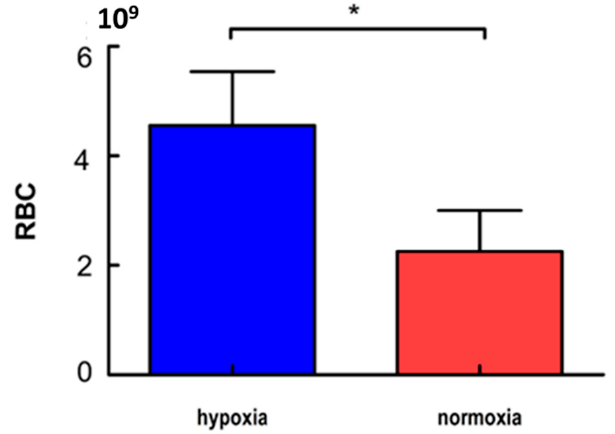
Figure 1. Erythrocyte numbers in the hypoxia zebrafish and normoxia zebrafish (* p < 0.05 indicates a significant difference between the hypoxia and normoxia group). Values are the mean erythrocyte numbers ± SD (n = 3). Table 2. The size of different types of blood cells in the two groups ( µ m). Normoxia Hypoxia